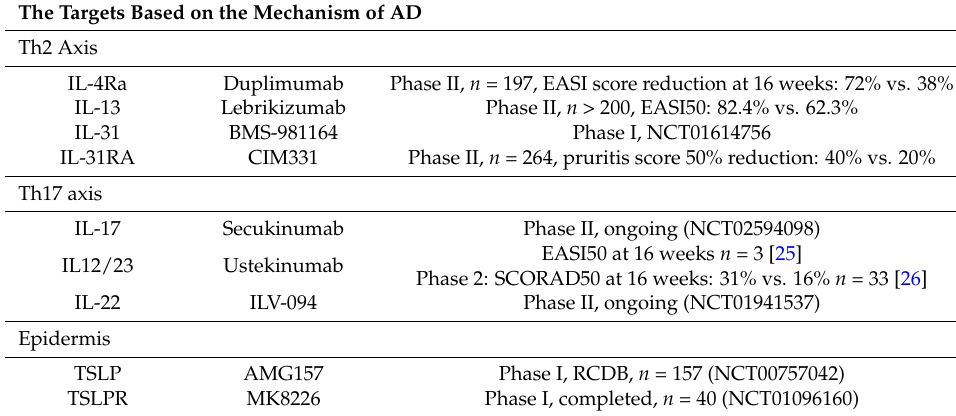
Table 1. Potential targeted biologics against inflammatory pruritus in atopic dermatitis (AD). The Targets Based on the Mechanism of